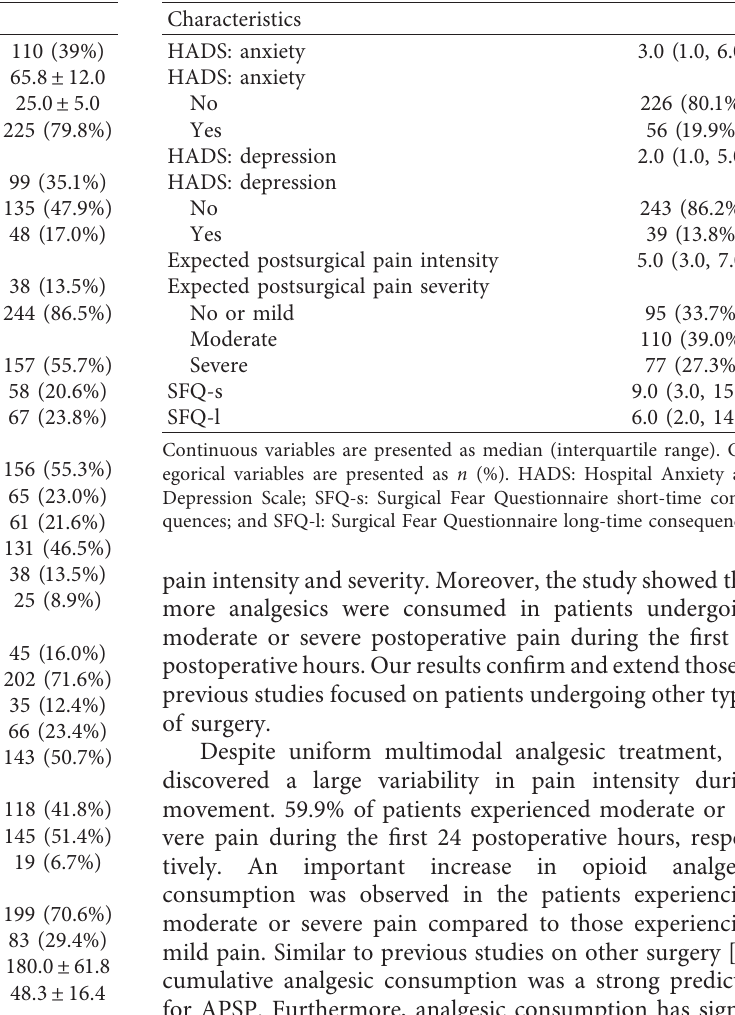
Table 1: Demographic and clinical characteristics of patients. Table 2: Psychological characteristics of